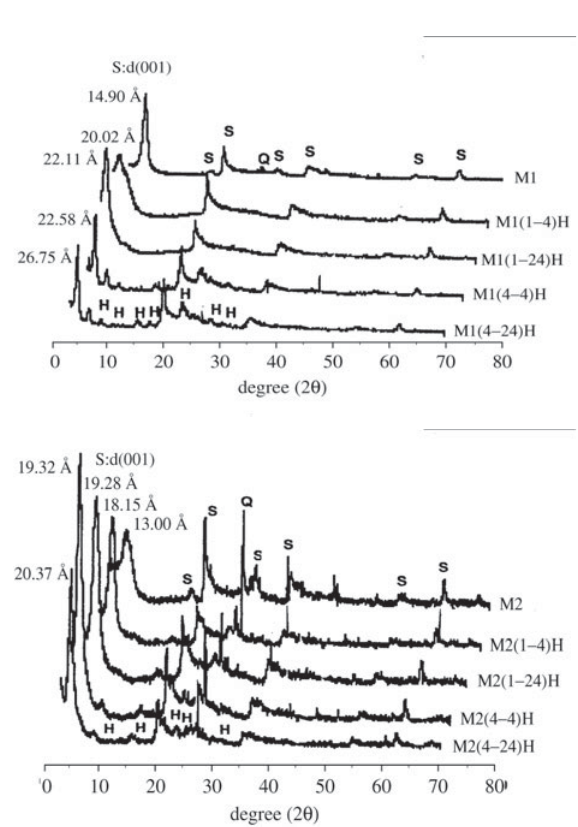
Figure 3. X-ray diffraction: a) HDP-M1 serie; b) HDP-M2 serie. H: hexadecilpyridinium specie; S: smectite; Q: